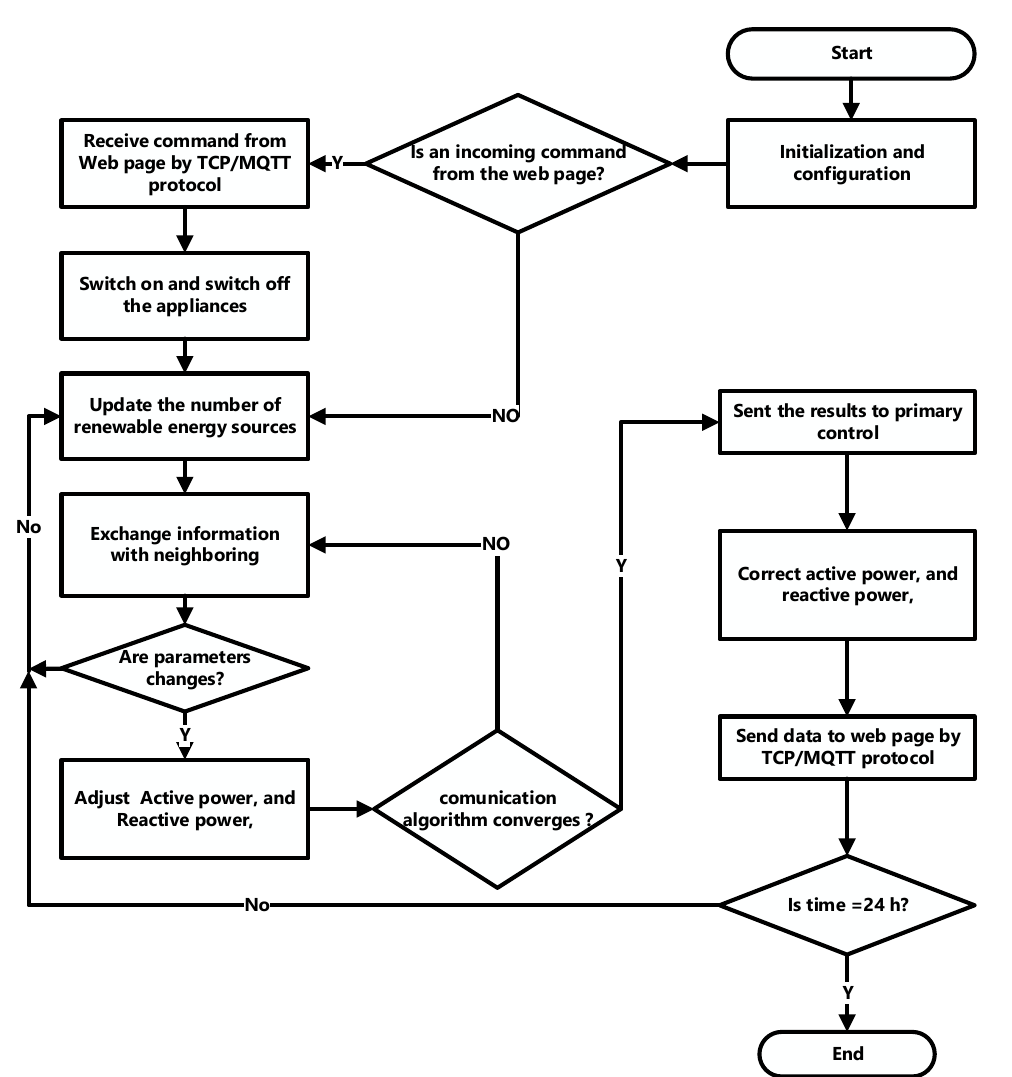
Figure 7. The proposed method flowchart.